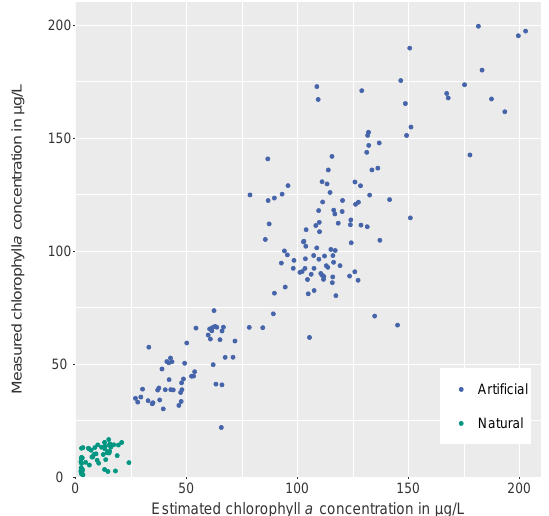
Figure 5. Examplary scatterplot of the ANN regressor showing the estimated vs. the measured chlorophyll a concentration for the 4nm spectral resolution. The color defines the status of the water body: natural waters (green) and artificial ponds (blue).